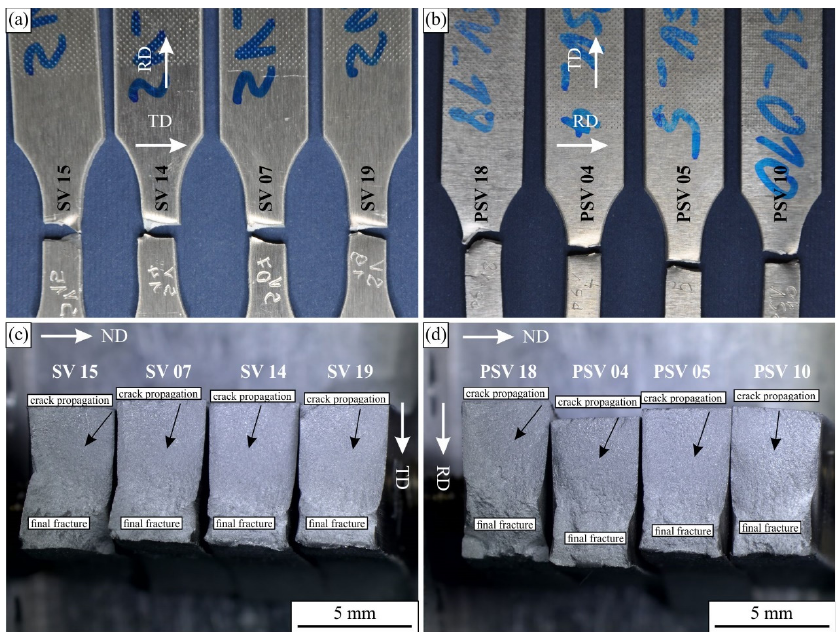
Figure 9. The light micrographs of the fractured surfaces of the selected fatigue samples: ( a , c ) longitudinal layout and ( b , d ) transverse layout (ND—normal direction, RD—rolling direction, TD—transverse direction).